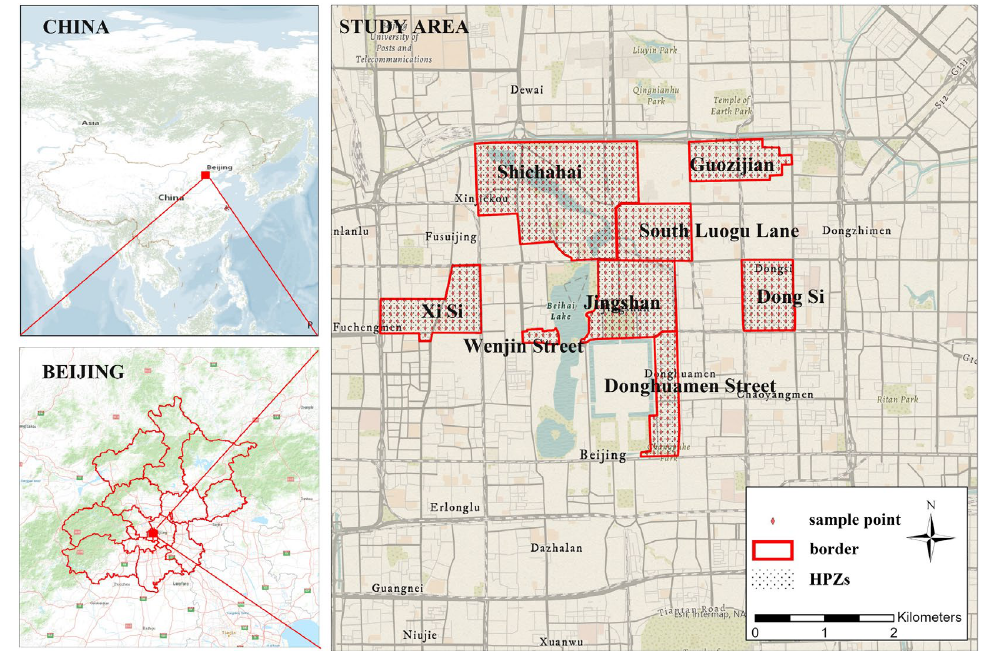
Figure 1. Study area and the locations of 8 HPZs.